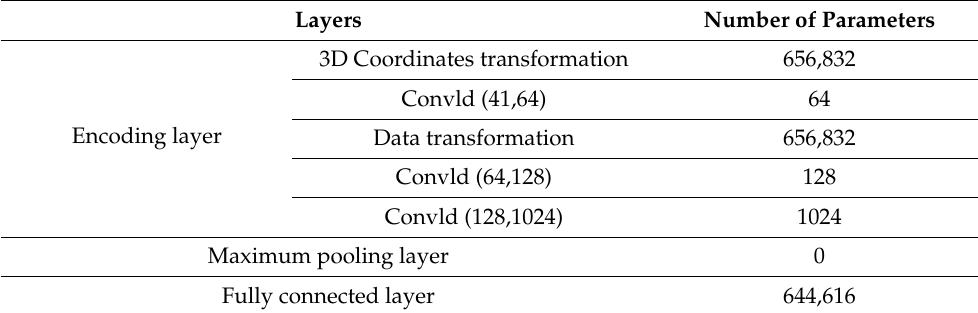
Table 2. The specific number of different layers.